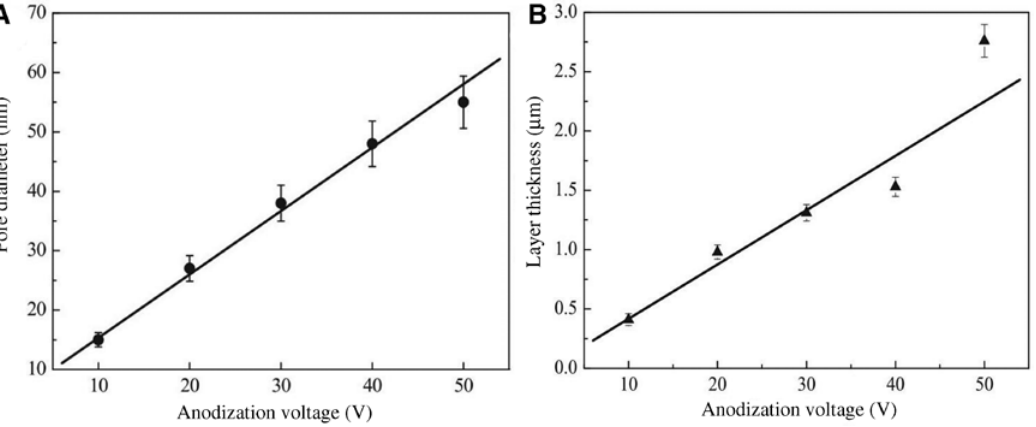
NTAs anodized in F - - 2